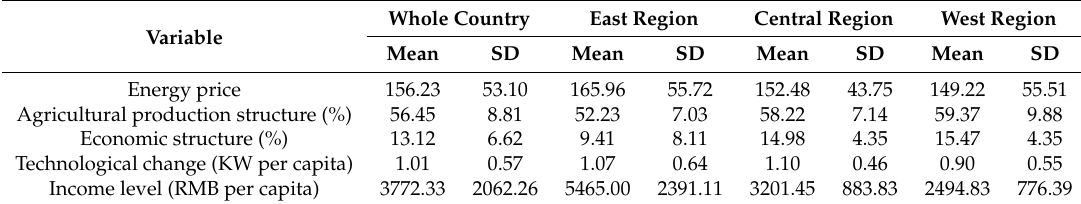
Table 2. Summary statistics of variables in regression